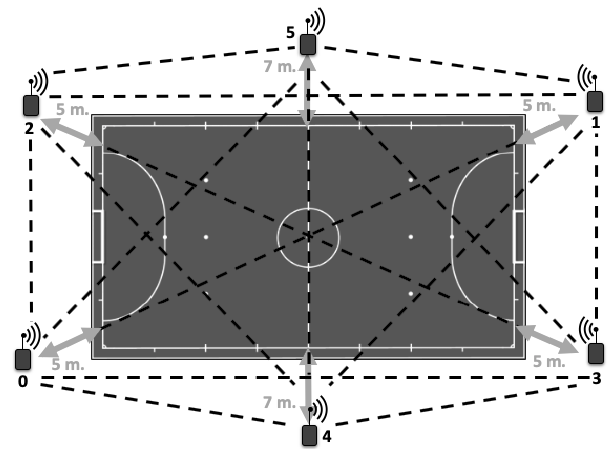
Figure 1. Antenna distribution of the Local Positioning System and distance reference to the futsal pitch. Arrows indicate distance from the antennas to the court and black lines indicate communication between antennas.